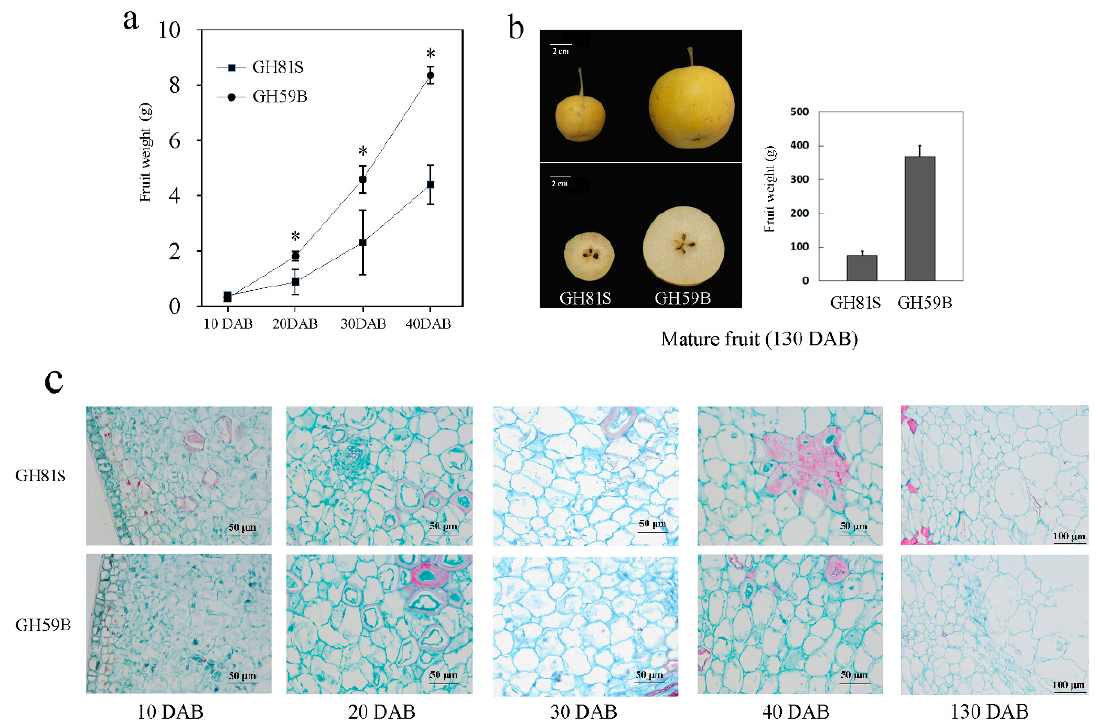
Figure 1. Development of the fruit of ‘GH81S’ and ‘GH59B’ in 40 days after blossom. ( a ) Fruit weight. The asterisks represent significant differences determined by Student’s t test at p < 0.05. ( b ) The mature fruit, ( c ) Histological sections of young fruit.